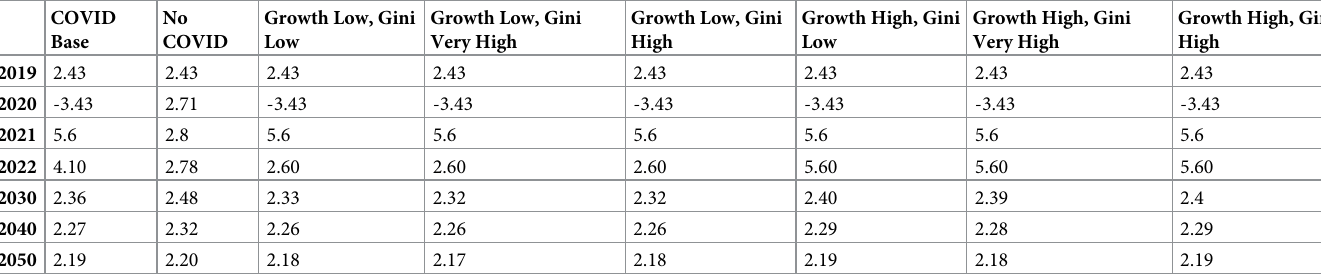
Table 2. GDP (MER in $2011 USD) annual growth rate by decade and